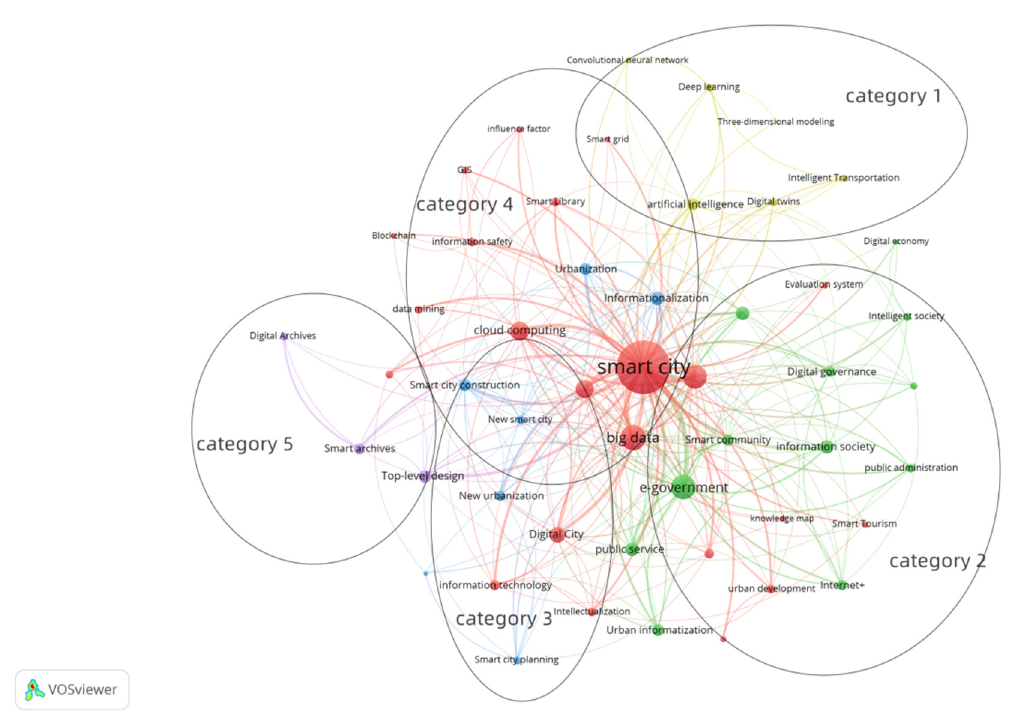
Figure 6. High-frequency keywords clustering co-occurrence mapping.